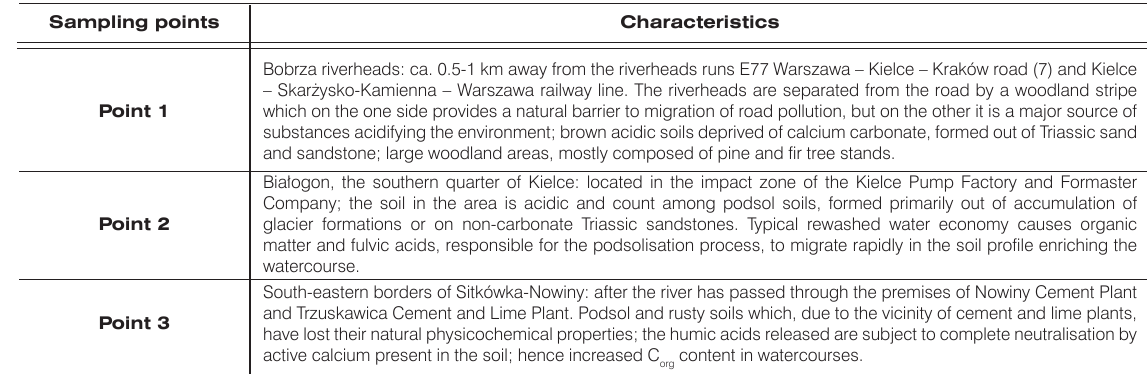
Table 1. Characteristics of environmental sampling